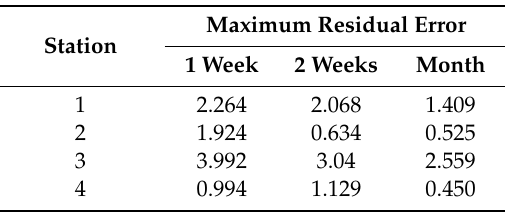
Figure 7. Scatter plots between the observed and predicted value for Scenario 1. Table 8. Maximum residual error for DO.